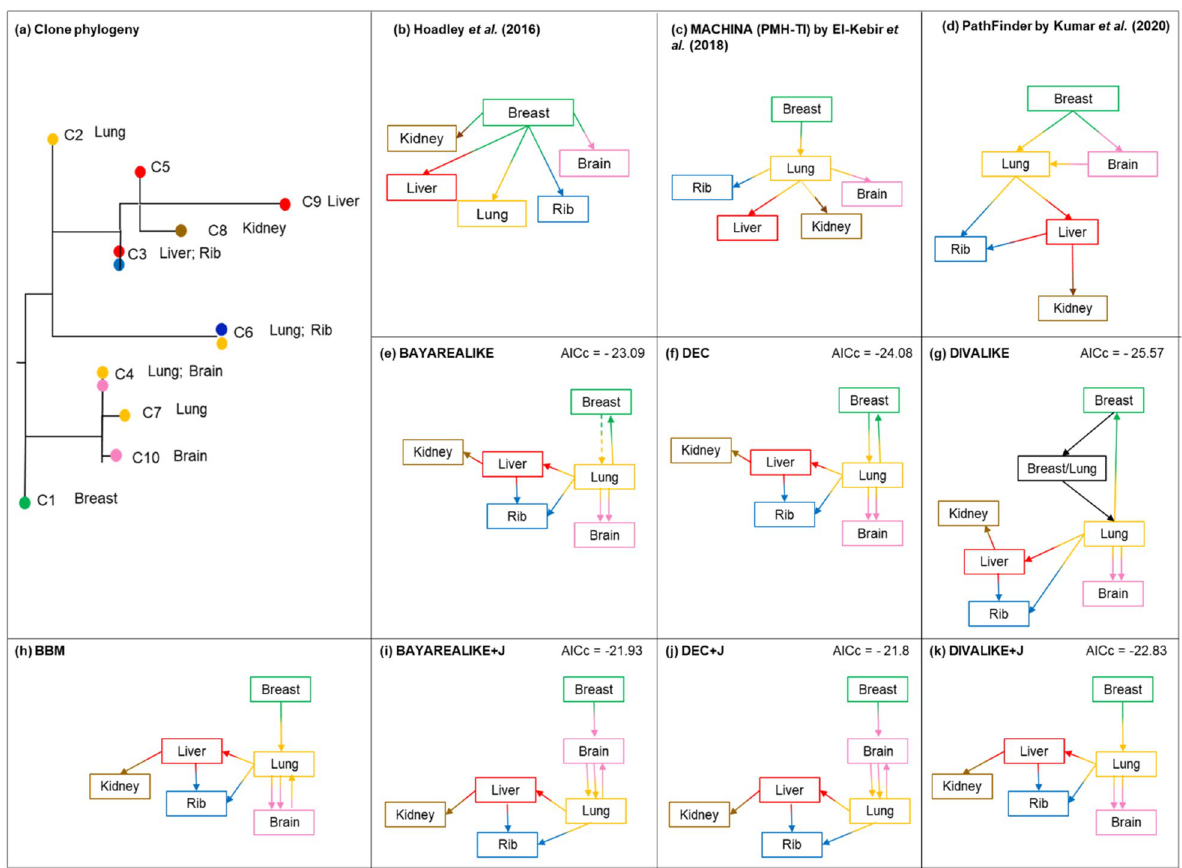
Figure 8. Analysis of Patient A7 with basal-like breast cancer 13 . ( a ) Clone phylogeny and tumor location of each clone reported in the original study. ( b – k ) Clone migration histories predicted by non-biogeographic and biogeographic models. Colors correspond to the tumor location where clones were sampled from. Values on the top right are AICcs. Clone migration history inferred by BAYAREALIKE (panel e ) predicted the origin of metastasis to be from lung tissue, but the estimated probability value of lung at the root of the tree was very low and similar to that for breast tissue (primary tumor). We show the migration history starting from breast tissue (dotted line) because the primary tumor was found there ( e